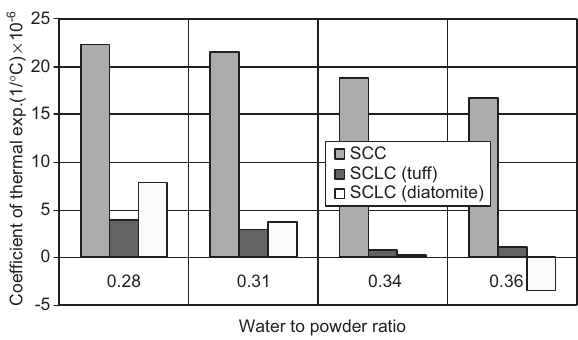
Figure 15 Comparison of CTE values of SCC and SCLC at 635 ° C.